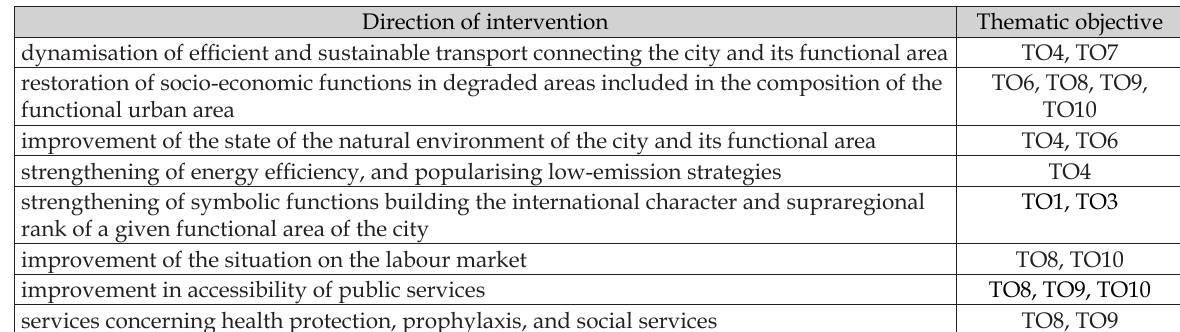
Table 2. Combining the directions of intervention with thematic objectives. Direction of